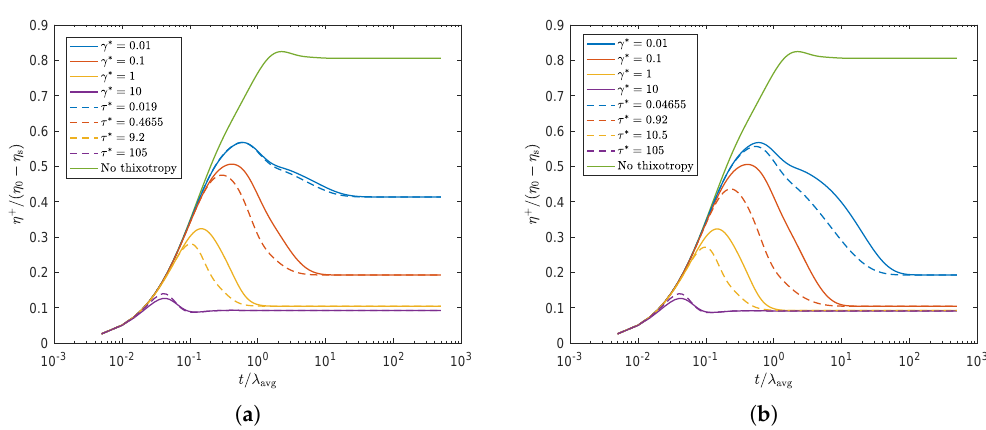
Figure 8. Transient polymer viscosity for ˙ γ c , where γ ∗ and τ ∗ are chosen such that ξ eq is matched for the rate and stress-controlled approach to obtain the same steady-state rheology for both models. ( a ) λ θ = 10 λ avg . ( b ) λ θ = 100 λ avg . The stress-controlled approach predicts a smaller overshoot compared to the rate- controlled approach for all damage parameters except the highest, for which a slightly higher overshoot is predicted by the stress-controlled approach. Figure 9 shows the equilib- rium value of ξ in steady state for different Weissenberg numbers for both approaches. The vertical black dotted line indicates the Weissenberg number corresponding to the character- istic shear rate for which both models match. This figure shows that ξ eq is indeed matched for the characteristic shear rate. It is however clear that for ˙ γ < ˙ γ c , the stress-controlled approach predicts a smaller value for ξ eq (indicating more structural damage), whereas for ˙ γ > ˙ γ c , the stress-controlled approach predicts a larger value for ξ eq (less structural damage) compared to the rate-controlled approach.